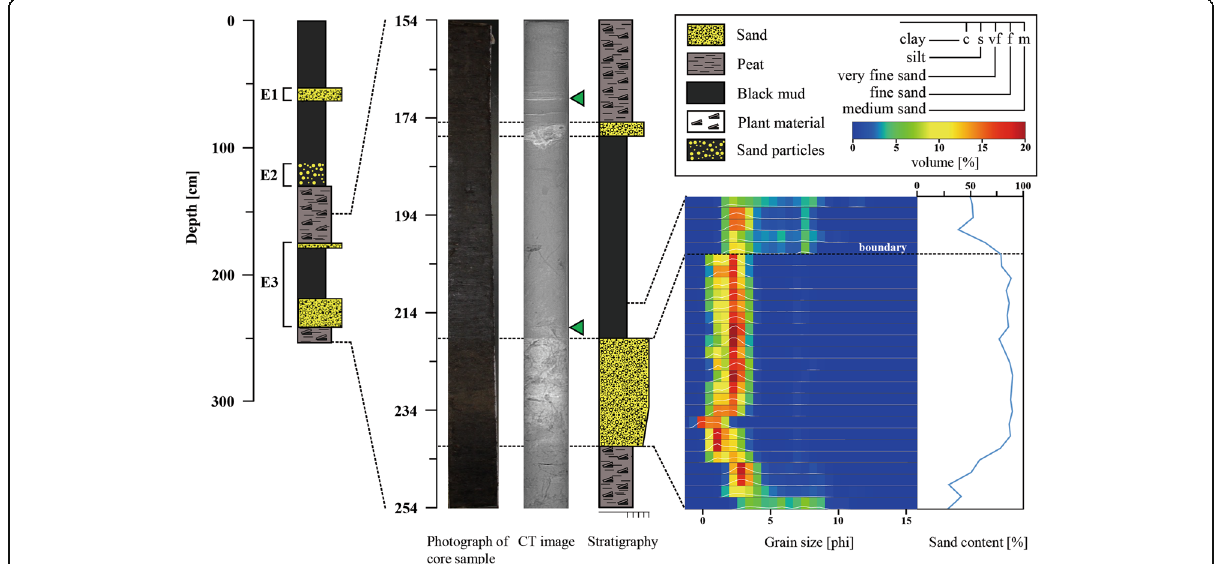
Fig. 4 Columnar section of KBT4 core: a close-up photograph at 154 – 254 cm depth, CT images, columnar section, grain size, and sand content are also shown. E1, E2, and E3 denote event sand layers. In the CT image, white parts denote sand layers with higher density, whereas gray parts denote mud or peat. White parts represent the apparent direct top of the sand layer (green arrowheads show) in the CT image, indicating that sands were contaminated into the mud layer. For the grain size diagram, the horizontal axis is grain size (phi). The volume percent (%) of each grain size is indicated by the color